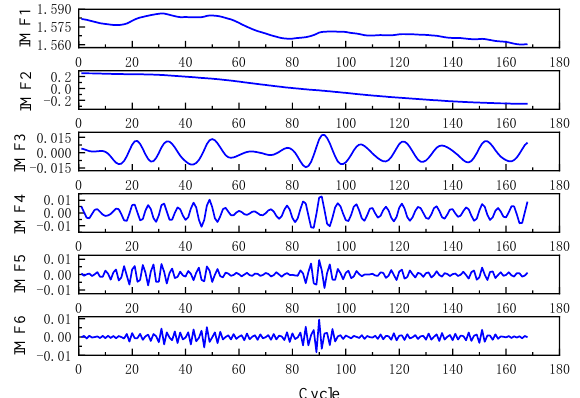
Figure 7. Decomposition effect when K = 6, α = 800.